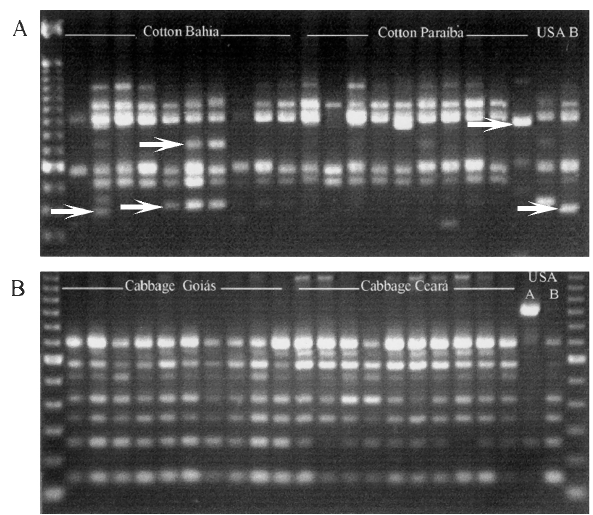
Figure 2 - Example of RAPD patterns generated by primers OPA-05 (A) and OPA-13 (B). Arrows indicate the polymorphic fragments used in the analysis. Lanes 1 in panel A and lanes 1 and 24 in panel B are 100 bp DNA